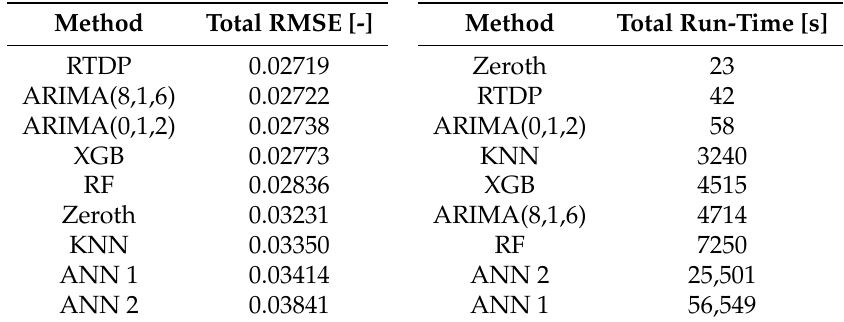
Figure 4. Comparison of the prediction accuracy waveforms of the methods used with the new prediction method RTDP. The moving RMSE was calculated as the RMSE of a moving 300 samples wide window. Table 2. The ranked results are summarized here by the total RMSE and also by the total runtime taken to calculate the predictions of the entire time series of supercomputer power